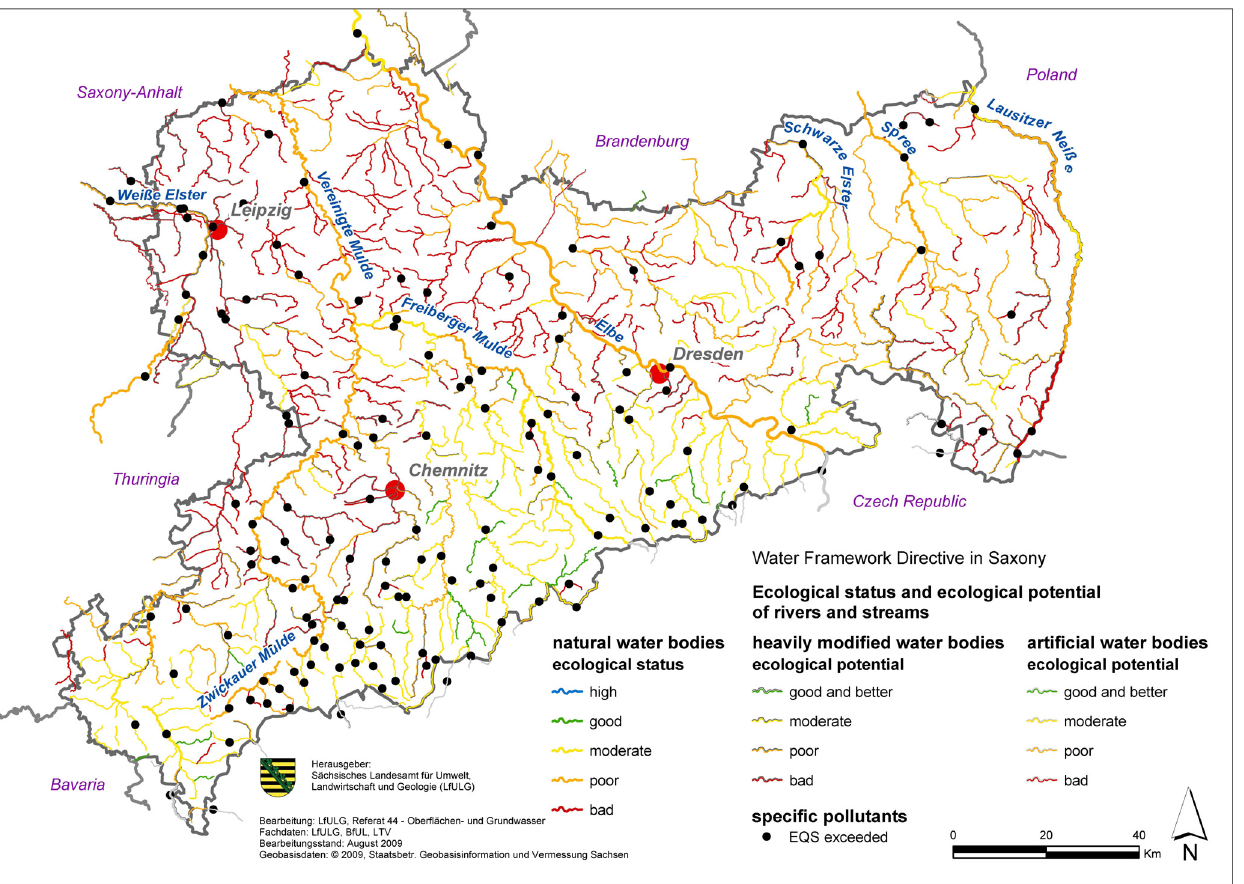
EQS = Environmental Quality